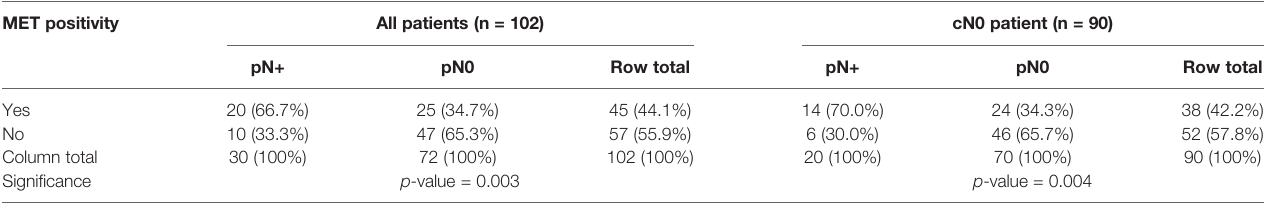
TABLE 2 | Cross-tabulations showing the relationship between MET positivity and pN status in all cancers (n=102) and in cN0 cancers (n=90). MET positivity